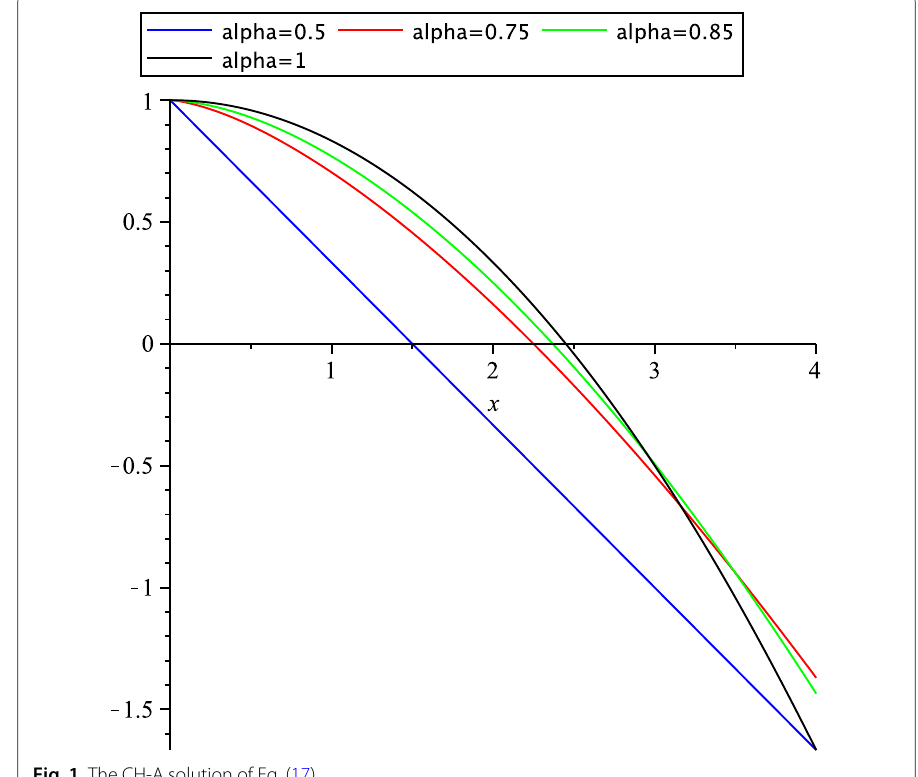
Fig. 1 The CH-A solution of Eq.